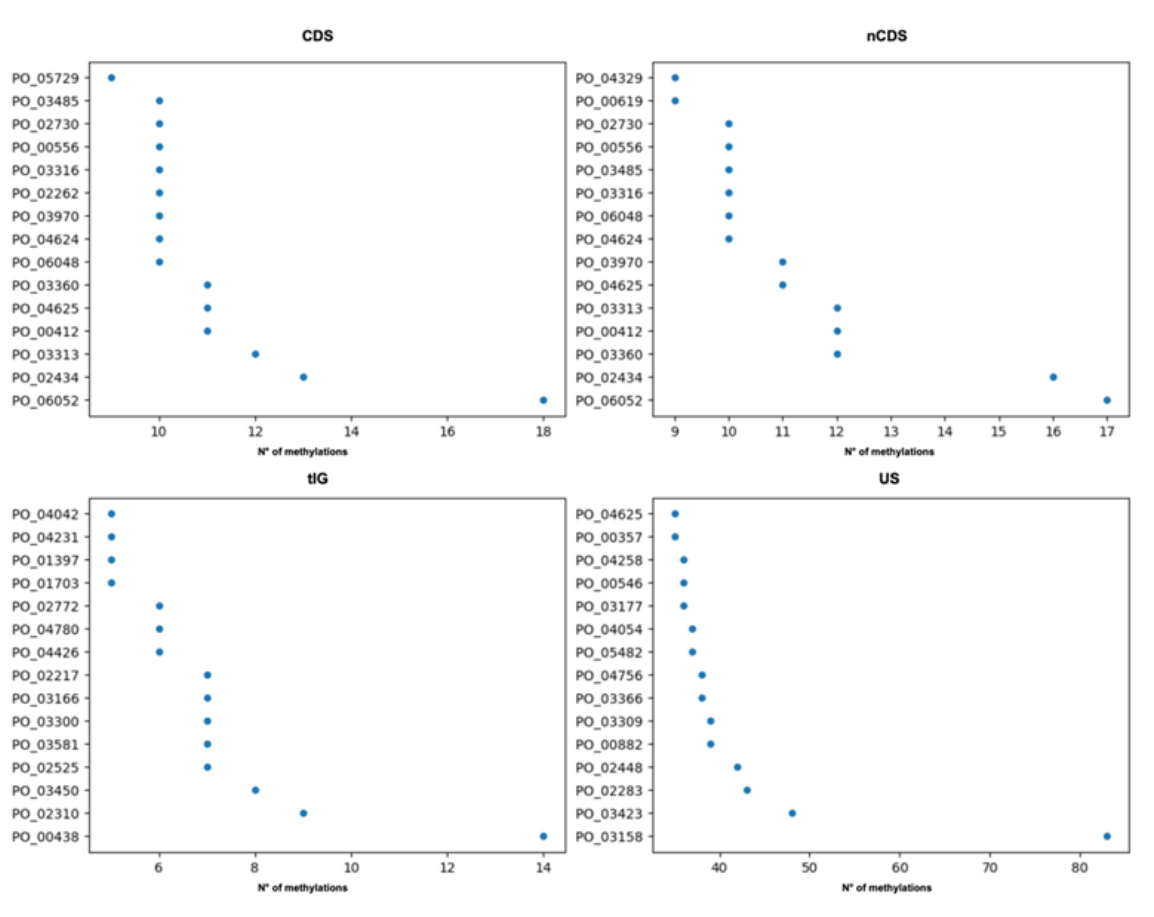
Figure 3. Scatter plots of GANTC motif in S. meliloti FSM-MA. The Y-axis reports geneIDs, whereas the X-axis reports the number of methylations found for each geneID. GeneIDs are taken from the annotation (see GitHub repository for the annotation files: https://github.com/combogenomics/MeStudio (accessed on 4 October 2022)). Plots for the different categories of methylated sites (CDS, nCDS, tIG, and US) are reported.